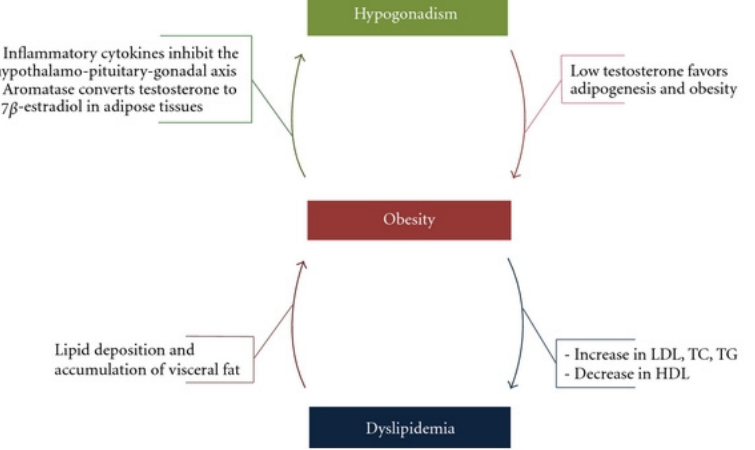
Figure 2. The vicious cycle of hypogonadism, obesity and dyslipidaemia by Fahed et al. via Creative Commons Attribution License [22].